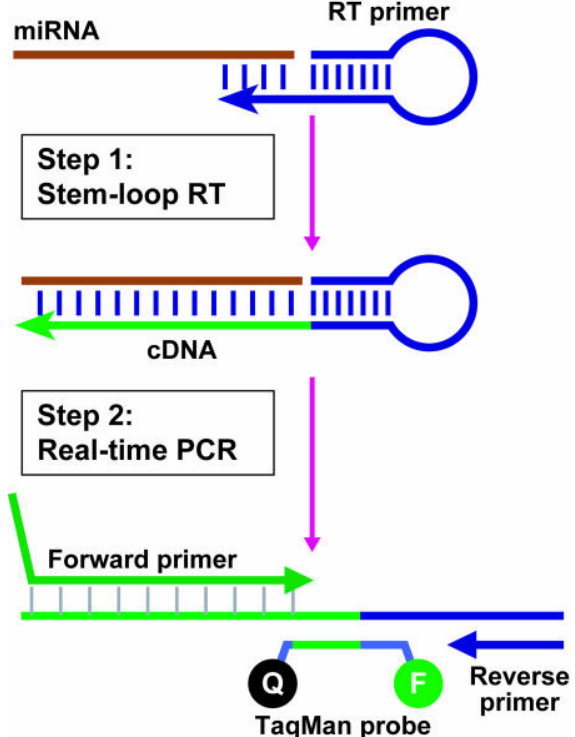
FIGURE 1. Schematic description of TaqMan-based real-time quantification of miRNAs includes two steps: stem-loop RT and real- time PCR. Stem-loop RT primers bind to at the 3 ′ portion of miRNA molecules and are reverse transcribed with reverse transcriptase. Then, the RT product is quantified using conventional TaqMan PCR that includes miRNA-specific forward primer, reverse primer, and dye-labeled TaqMan probes. The purpose of tailed forward primer at 5 ′ is to increase its melting Tm, depending on the sequence composition of miRNA molecules. An intermediate step of pre-PCR amplification can be added in multiplex reactions (see explanation in the text). The figure is reproduced from Chen et